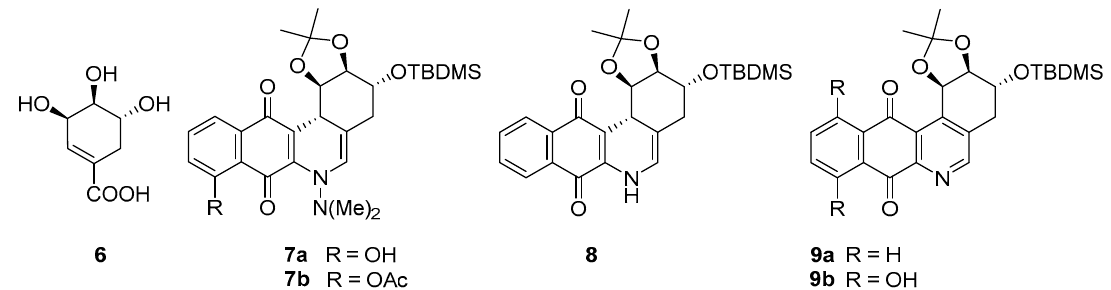
Figure 2. Chemical structures of (-)-shikimic acid and 6-aza-angucyclinone derivatives.